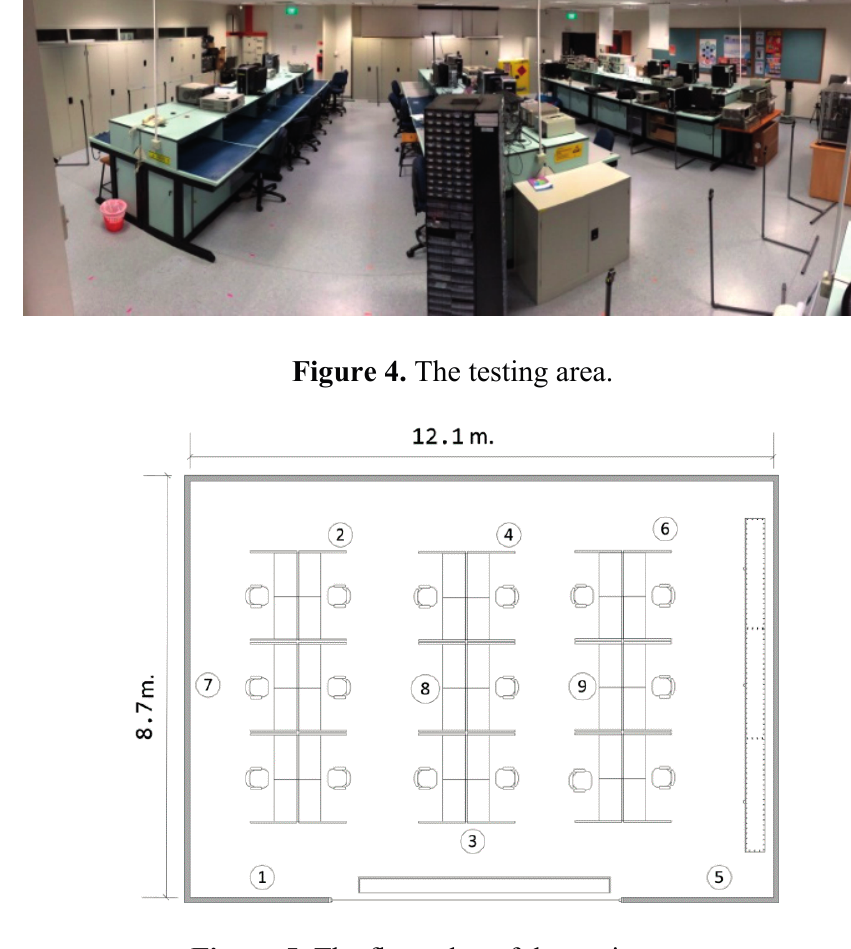
Figure 5. The floor plan of the testing